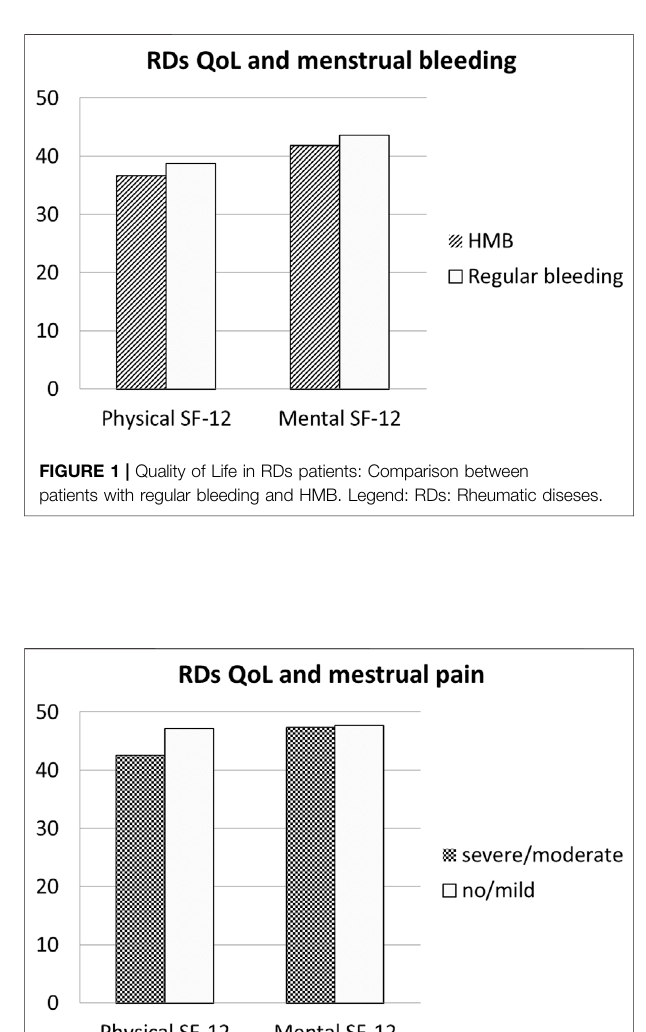
RDs Versus Control Group Women with RDs reported more frequent HMB during adolescence (51.7 and 25.4%, respectively; p = .0001) and adult life (37.7 and 25.9%, respectively; p = .0065). Dysmenorrhea in adolescence was also more common (55.6 and 45.4%, respectively; p = .0338).